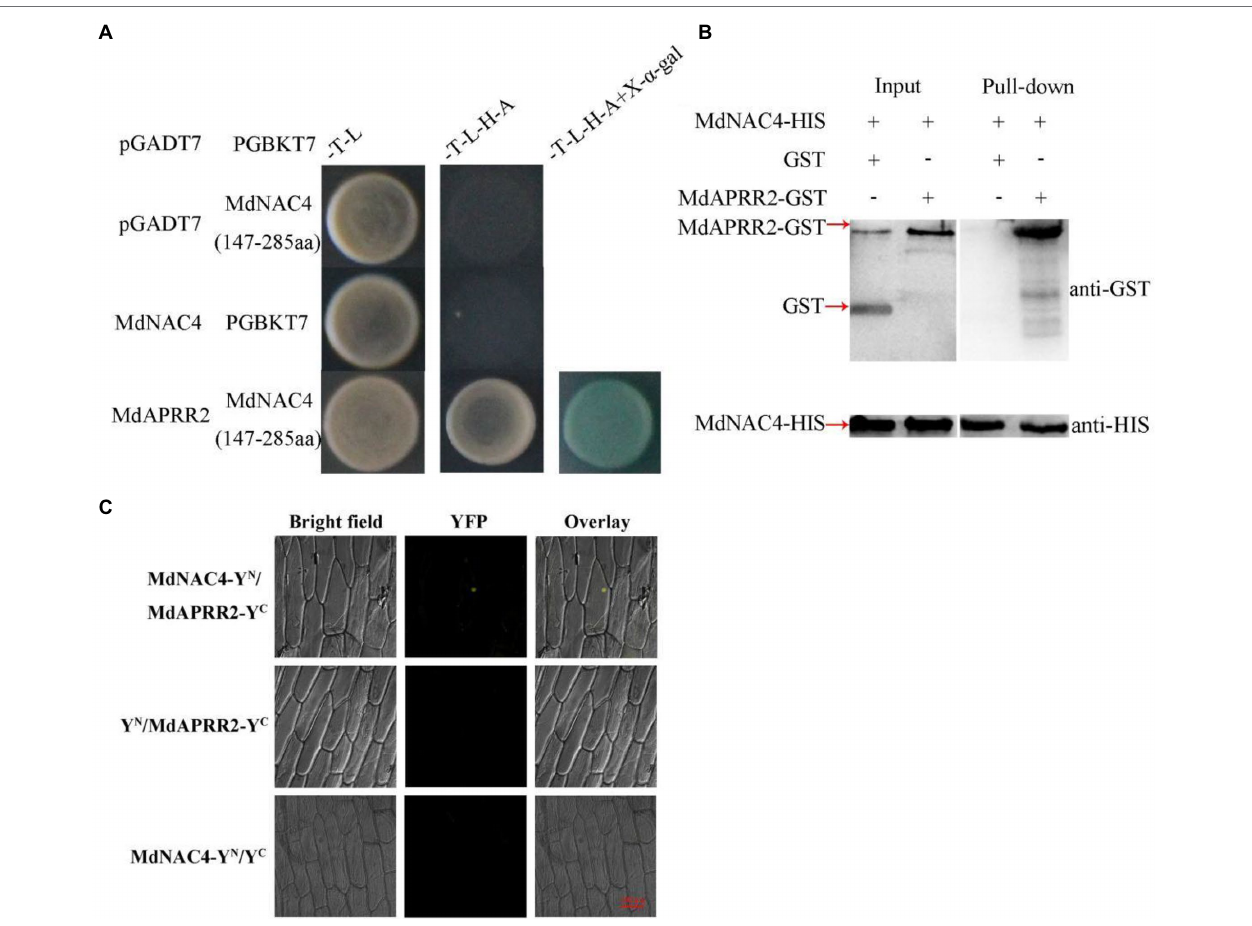
FIGURE 5 | MdNAC4 interacted with MdAPRR. (A) Interaction between MdNAC4 and MdAPPRR2 via a Y2H assay; (B) Interaction between MdNAC4 and MdAPPRR2 via a pull-down assay; (C) Interaction between MdNAC4 and MdAPPRR2 via a BiFC